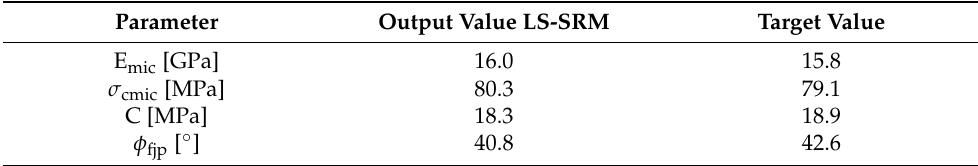
Figure 7. Results of the intact rock models on rock mass scale, i.e., a massive cube of 50 m edge length. ( a ) Stress–strain curve for the intact rock, including the evolution of number of cracks; ( b ) Results of triaxial experiments using various confining pressures. Table 6. Results for the intact rock mass calibration.